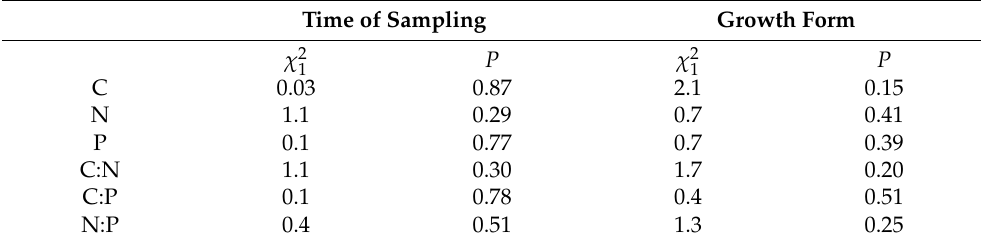
Table 2. Mixed-effects model to test the effects of the time of sampling (early versus late summer) and growth forms (rosette, large growth form, new shoots) in Juncus bulbosus . Data from 2008 (see Methods). Bonferroni correction for multiple testing α = 0.05/12 = 0.004.